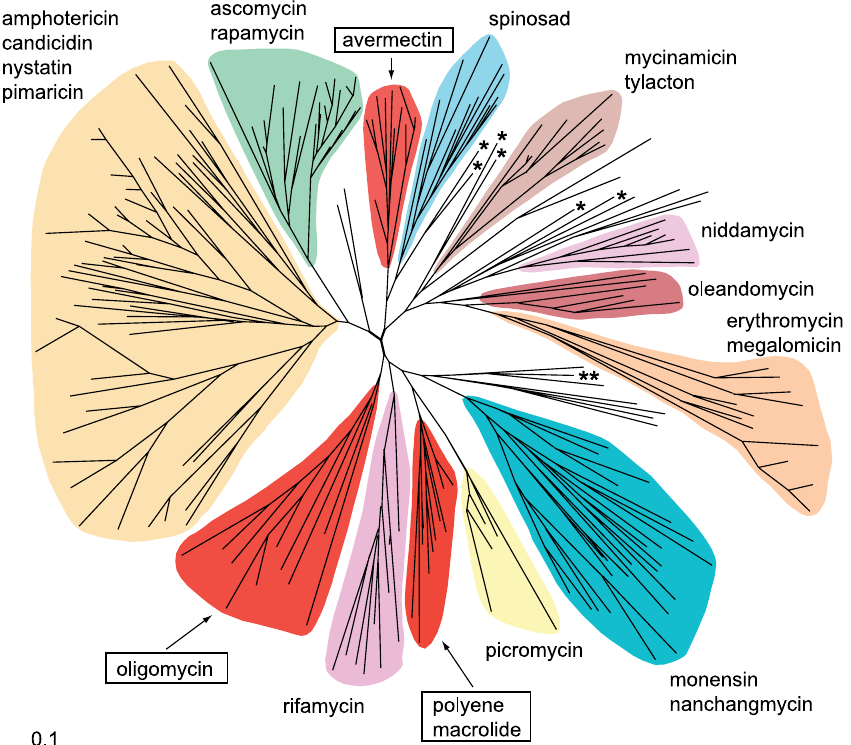
Figure 3. Phylogeny of the KS Domains of Selected PKS Clusters from Streptomyces Strains The tree was inferred by Bayesian estimation using amino acid sequences. The domains belonging to the three large PKS clusters of S. avermitilis are highlighted in red and marked by arrows. KS domains that are located outside the main oligomycin and polyene macrolide clades are labeled with a single asterisk and double asterisks, respectively. DOI: